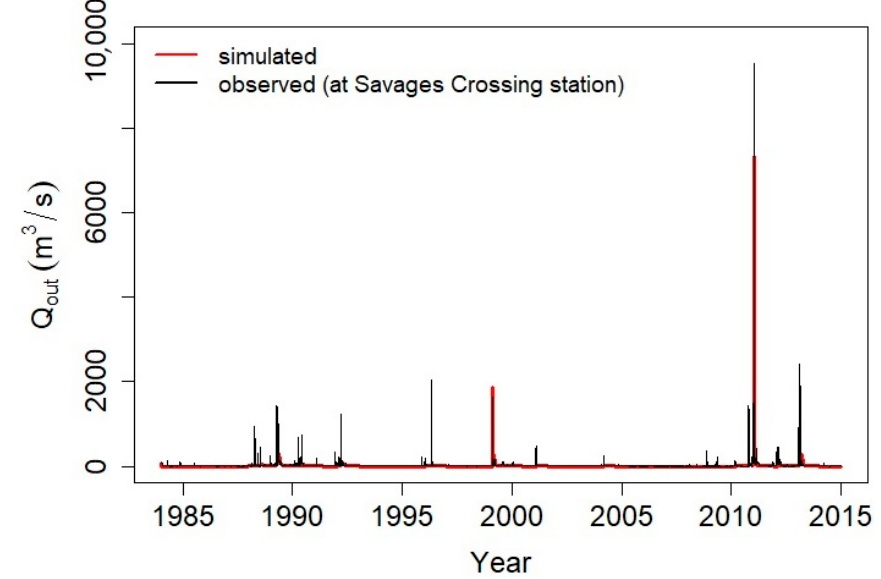
Figure 9. Evaluation of the socio-hydrological model comparing the simulated flow data (red) with the observed ones (black) at Savages Crossing from January 1984 to December 2014.